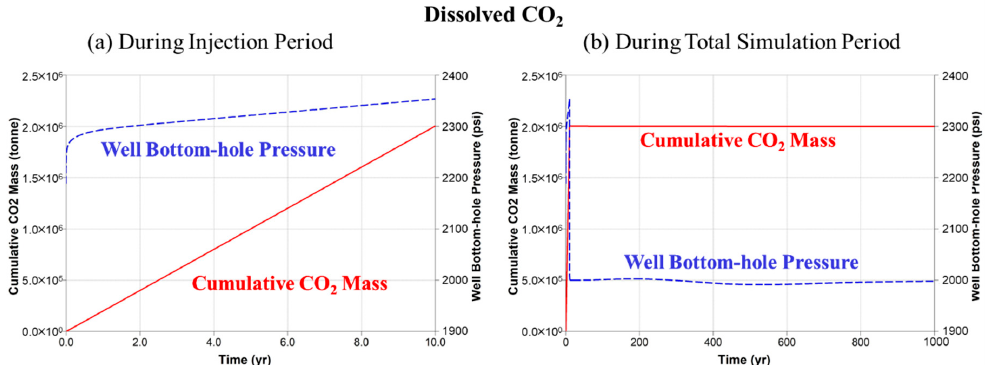
Figure 10. Injection profile of the dissolved CO 2 scenario: ( a ) During the injection period, ( b ) During the total simulation period.